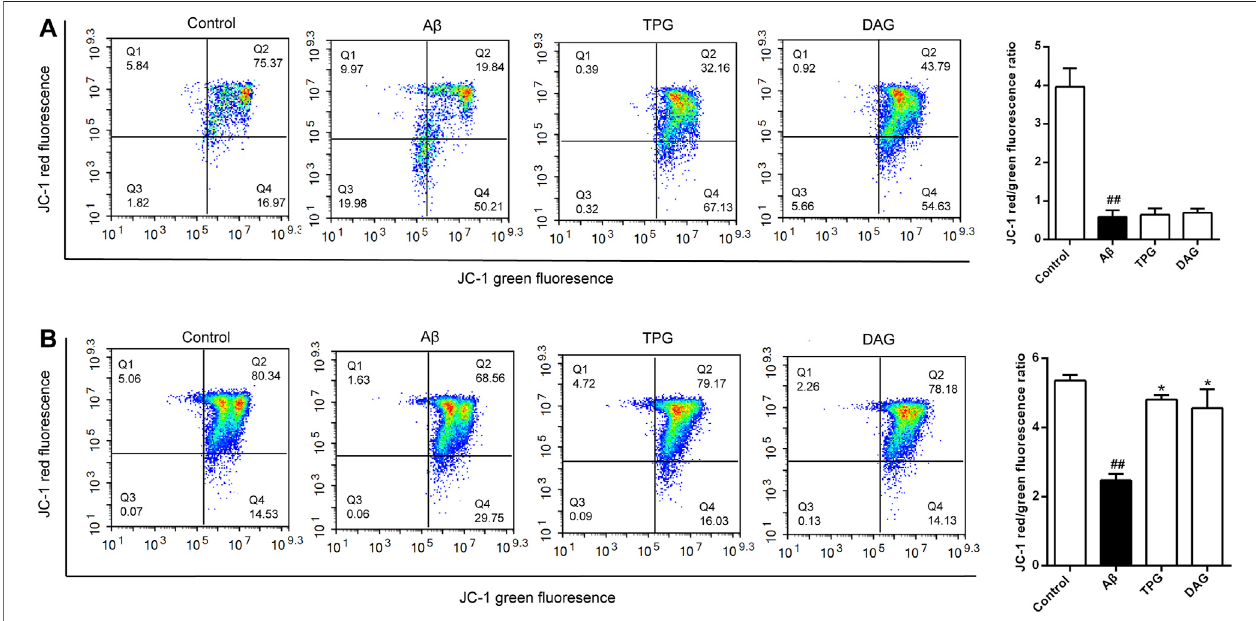
FIGURE 4| The improvement ofTPG and DAG on mitochondrial membrane potentialin A β 25 – 35 -exposed cells. Cells with high MMP promote the formation ofdye aggregates and fl uoresce red, while cells with low potential contain monomeric JC-1 and fl uoresce green. The ratio of red/green fl uorescence indicated MMP level in each group (A) Theratioofred/green fl uorescenceindifferentgroups after24 hofA β 25 – 35 -exposed cells (B) Theratioofred/green fl uorescence indifferentgroupsafter 4 h of A β 25 – 35 -exposed cells. All values were shown as mean ± SEM from three independent studies. Statistical analyses were performed using one-way ANOVA and Tukey-HSD post hoc comparisons. # p < 0.05, vs. control group; ## p < 0.01, vs. control group; * p ＜ 0.05, vs . A β 25 – 35 models. TPG, tortoise plastron gelatin; DAG, deer antler